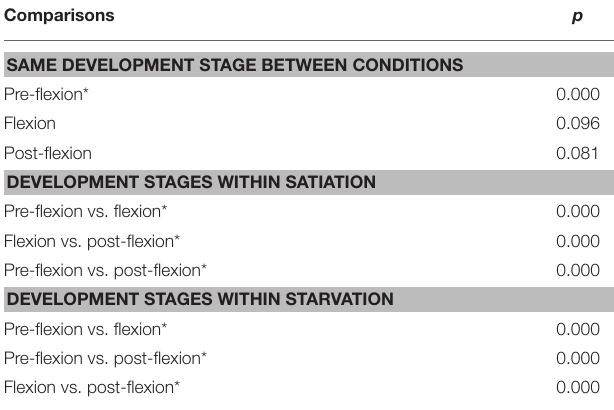
TABLE 2 | Significance level of the comparisons calculated with a Chi-square test for the absolute frequencies registered for the behavior exhibited by Sparus aurata larvae (unresponsive to water cues, coastal water preference, lagoon water preference, inconclusive behavior) during choice-chamber trials performed along ontogeny (pre-flexion, flexion, post-flexion) and in satiation and starvation conditions. Comparisons